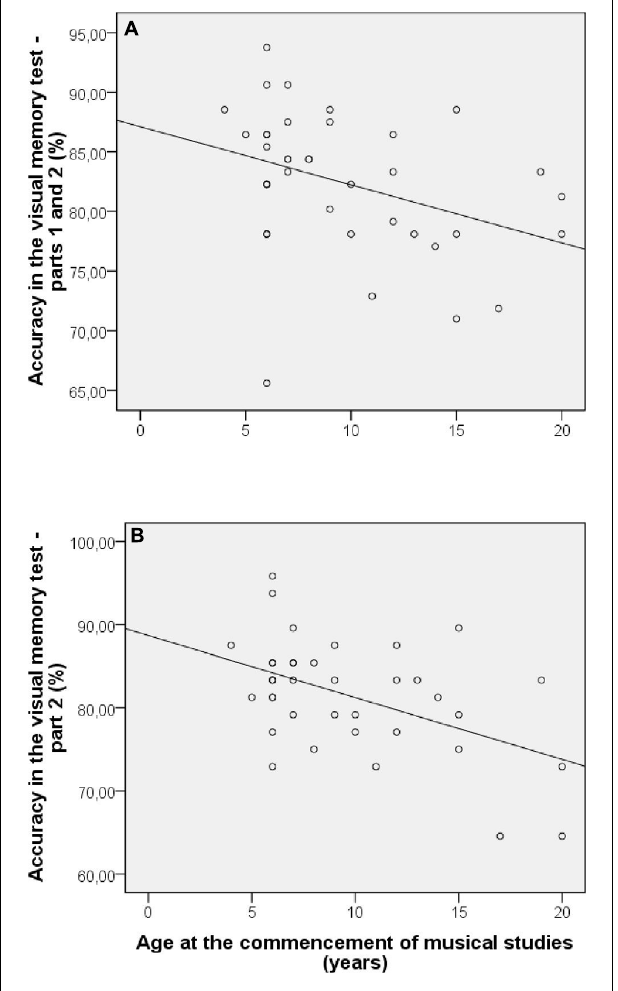
FIGURE 3 | Significant correlations ( p < 0.05) between age at the commencement of musical studies and accuracy in the visual memory test – parts 1 and 2 (A) and part 2